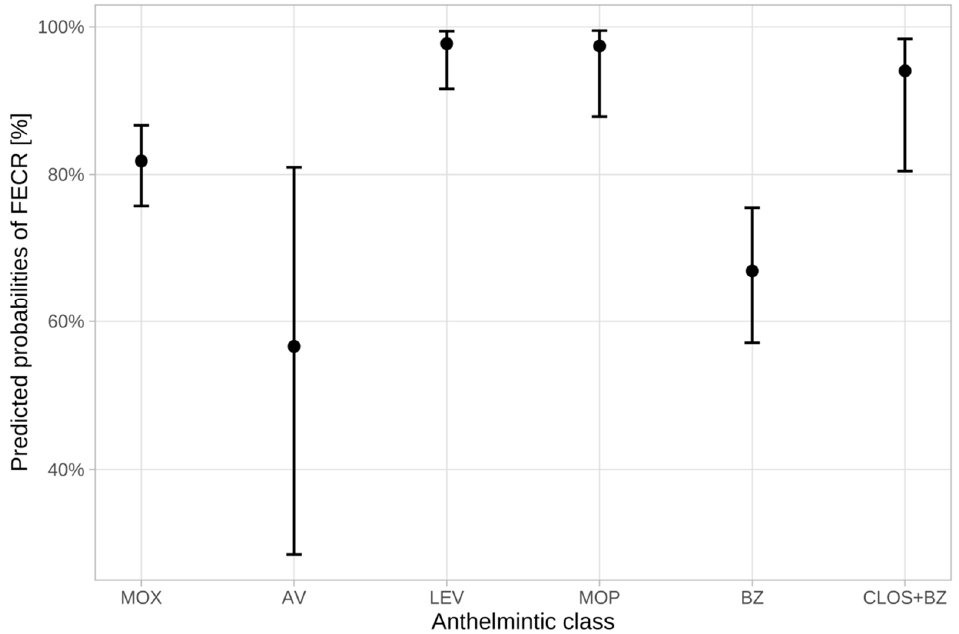
Figure 2. Predicted probabilities of faecal egg count reduction (FECR) in sheep for the various anthelmintic categories, with error bars indicating the 95% confidence interval. MOX = moxidectin; AV = avermectins, LEV = levamisole; MOP = monepantel; BZ = benzimidazoles; CLOS + BZ = closantel and mebendazole. Table 5. Results of pairwise comparisons of the examined anthelmintic categories regarding predicted probabilities of faecal egg count reduction in sheep. MOX = moxidectin; AV = avermectins, LEV = levamisole; MOP = monepantel; BZ = benzimidazoles; CLOS + BZ = closantel and mebendazole; OR = odds ratio; 95% CI = 95% confidence interval. Significant results ( p ≤ 0.05) and tendencies ( p > 0.05 and <0.1) and are both indicated in bold. Paired